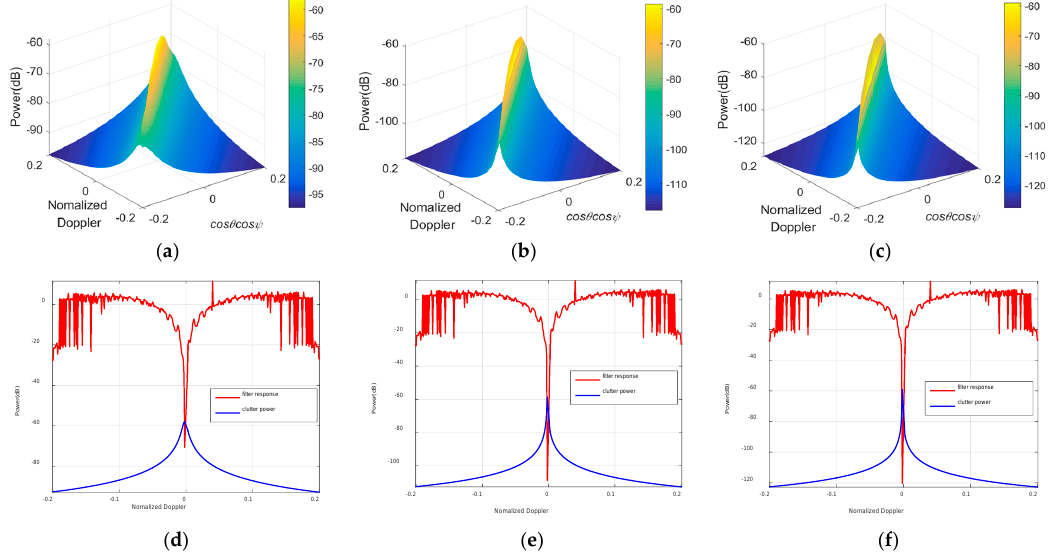
Figure 10. The minimum variance (MV) power spectrum of clutter and noise shows space-time coupling indicated briefly by the ridge-shaped field when the noise power is ( a ) − 60 dBm; ( b ) − 80 dBm; ( c ) − 90 dBm; the optimal response obeying linearly constrained minimum variance (LCMV) when the noise power is ( d ) − 60 dBm; ( e ) − 80 dBm; and ( f ) − 90 dBm. Obviously, the space-time coupled clutter is significantly suppressed to nearly − 70 dB, − 110 dB, and − 120 dB, which is ideal referring to the corresponding red lines, which illustrate the power at clutter ridges achieving about 40 dB, 60 dB, and 70 dB higher than that on the other field of